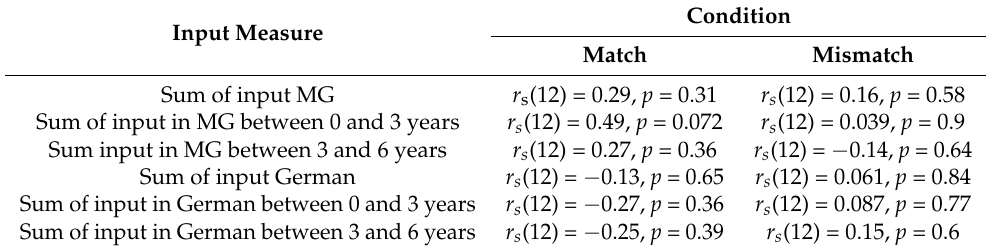
Table 9. Correlation coefficients and p-values for the correlations between correct performance in each condition and the measurements of sum of input in each language (current exposure), sum of input in each language between 0 and 3 years (total exposure in the first 3 years of life), sum input in each language between 3 and 6 years (total exposure between 3 and 6 years). MG: Modern Greek. Condition Input Measure Match Mismatch Sum of input MG r s (12) = 0.29, p = 0.31 r s (12) = 0.16, p = 0.58 Sum of input in MG between 0 and 3 years r s (12) = 0.49, p = 0.072 r s (12) = 0.039, p = 0.9 Sum input in MG between 3 and 6 years Sum of input German Sum of input in German between 0 and 3 years Sum of input in German between 3 and 6